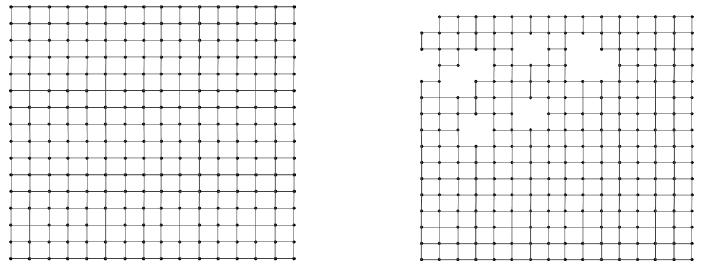
Figure 4. Demonstration of the topology changing for a square-tilting planar phased array with some antennas break